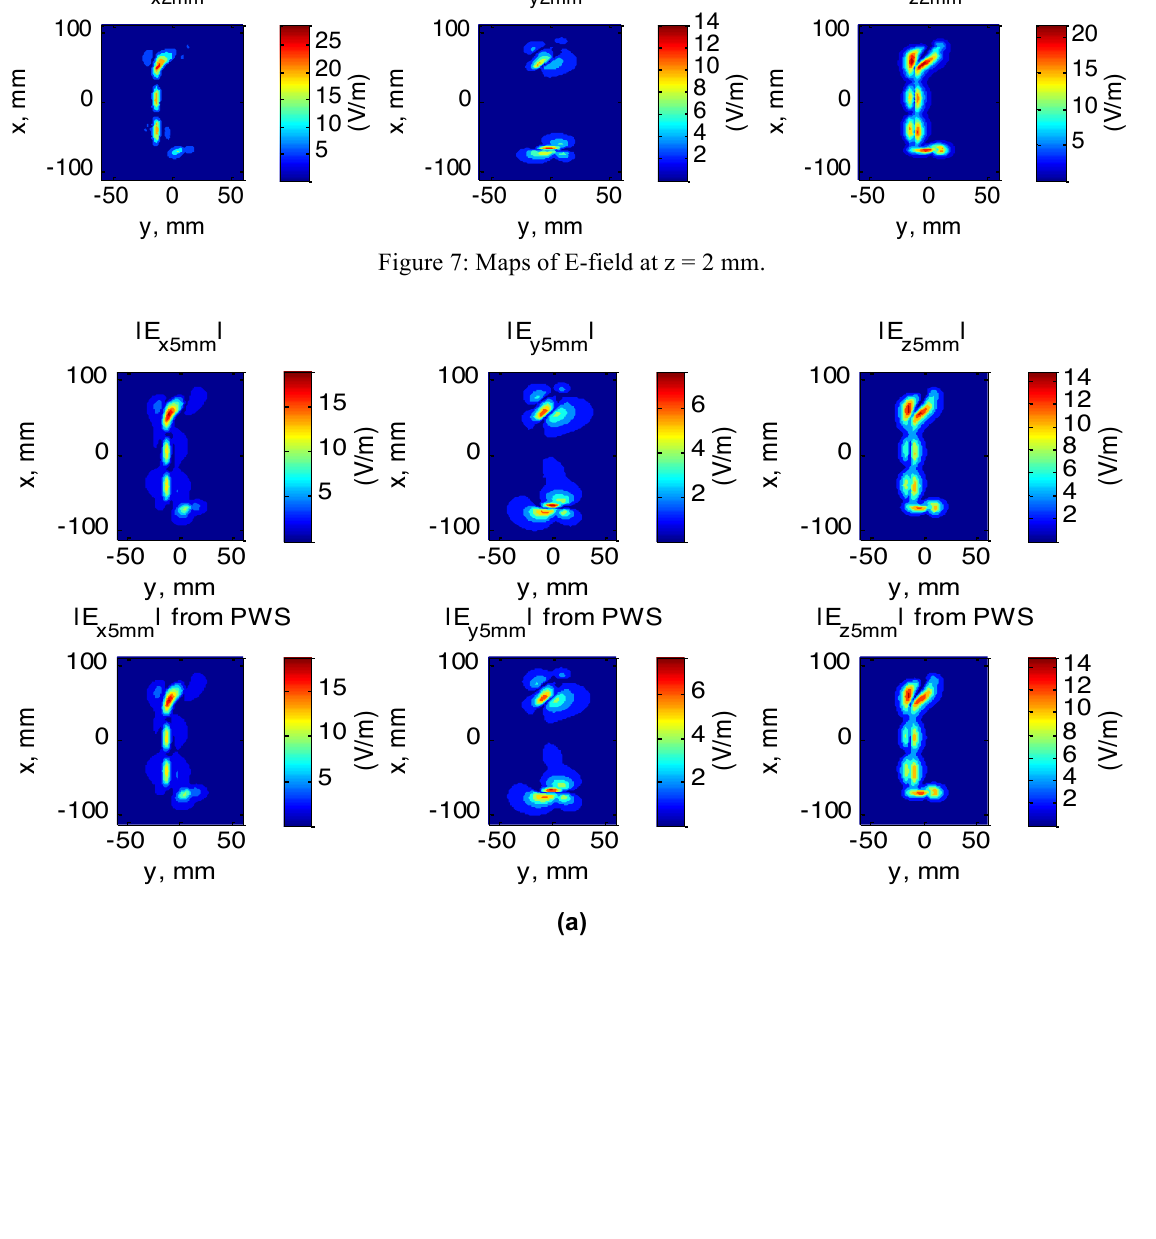
Figure 7: Maps of E-field at z = 2